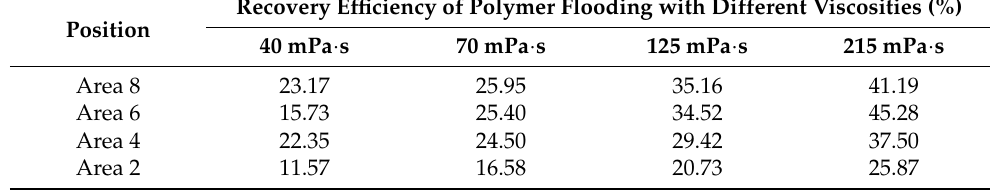
Table 4. Changes in the recovery factor in different areas of the diversion